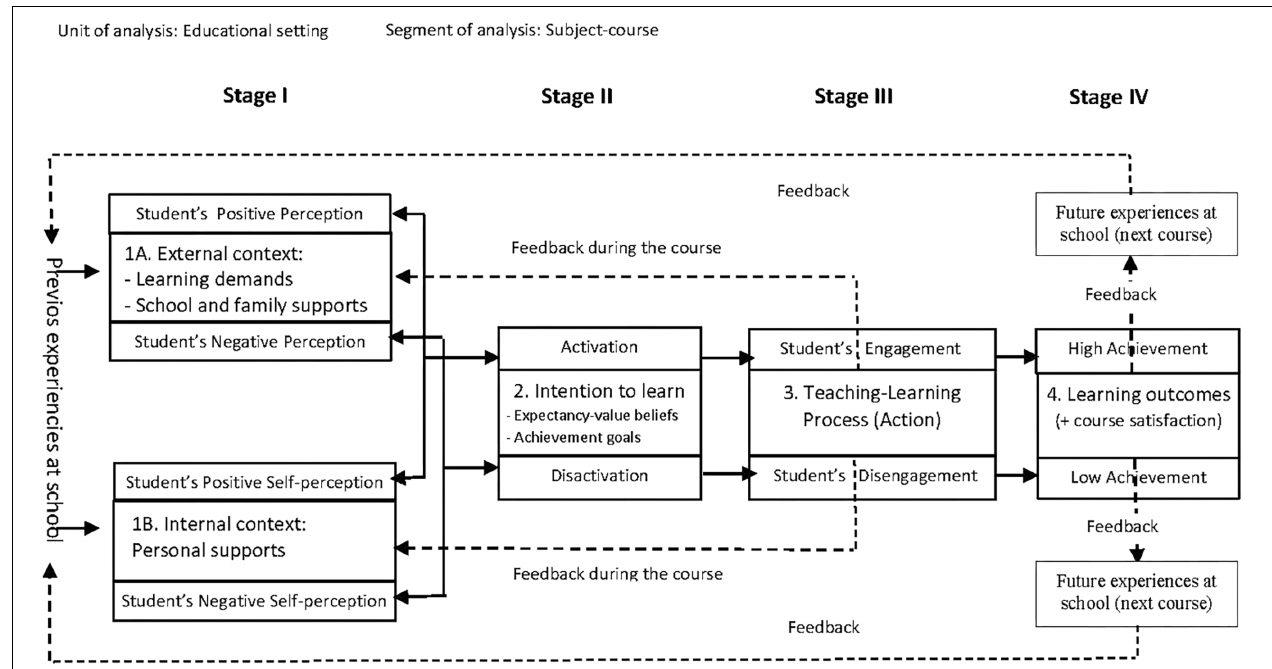
FIGURE 1 | MOCSE focused on students: structural configuration and relationship between